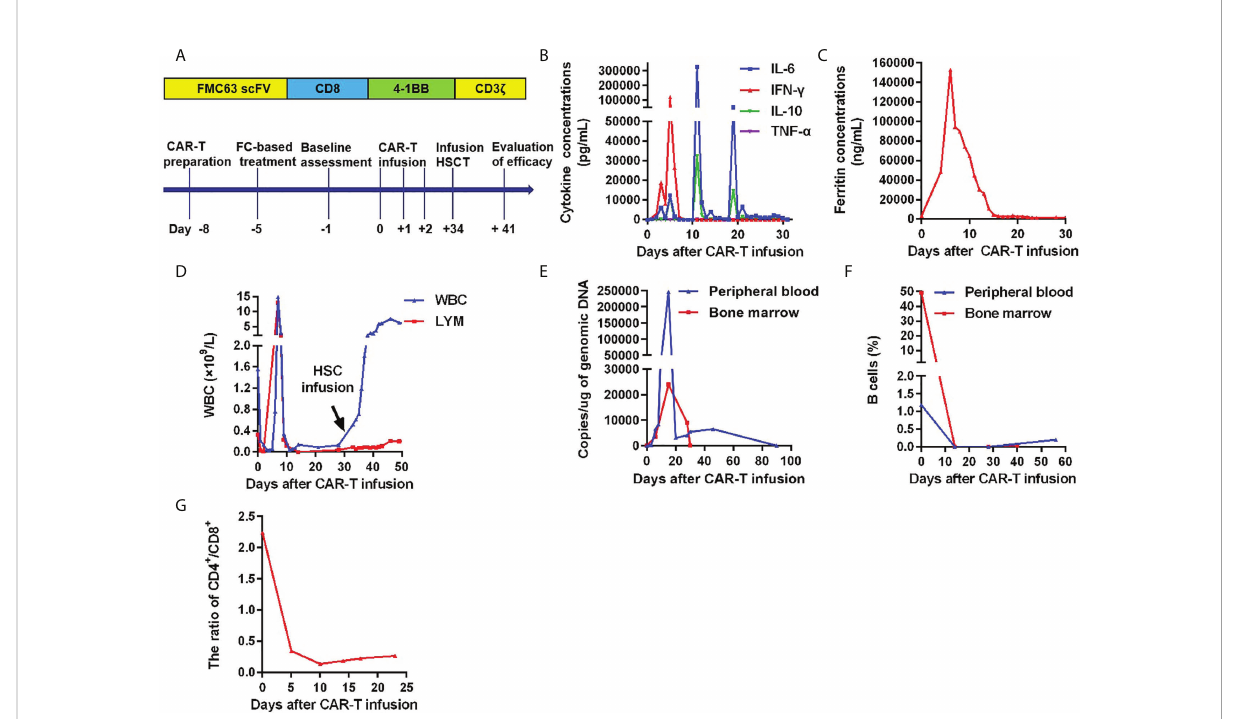
FIGURE 1 Infusion of anti-CD19 CAR-T cells and allo-HSC. (A) Anti-CD19 CAR design and the schematic clinical treatment protocol for anti-CD19 CAR-T cell therapy. The scFv region that recognizes CD19 was derived from the FMC63 monoclonal antibody. The CAR contained a 4-1BB costimulatory domain and a CD3 z T-cell activation domain (top panel). Clinical treatment protocol (bottom panel). (B) Levels of cytokines after CAR-T cell therapy. (C) Levels of ferritin after CAR-T cell therapy. (D) Dynamic white blood cell and lymphocyte numbers after CAR-T cell therapy. (E) Copies of lentivirus-containing CAR-T cells in the peripheral blood and bone marrow after CAR-T cell therapy. (F) CAR-T cells and B-cells after CAR-T cell therapy. (G) Ratio of CD4 + /CD8 + T cells in the peripheral blood after CAR-T cell